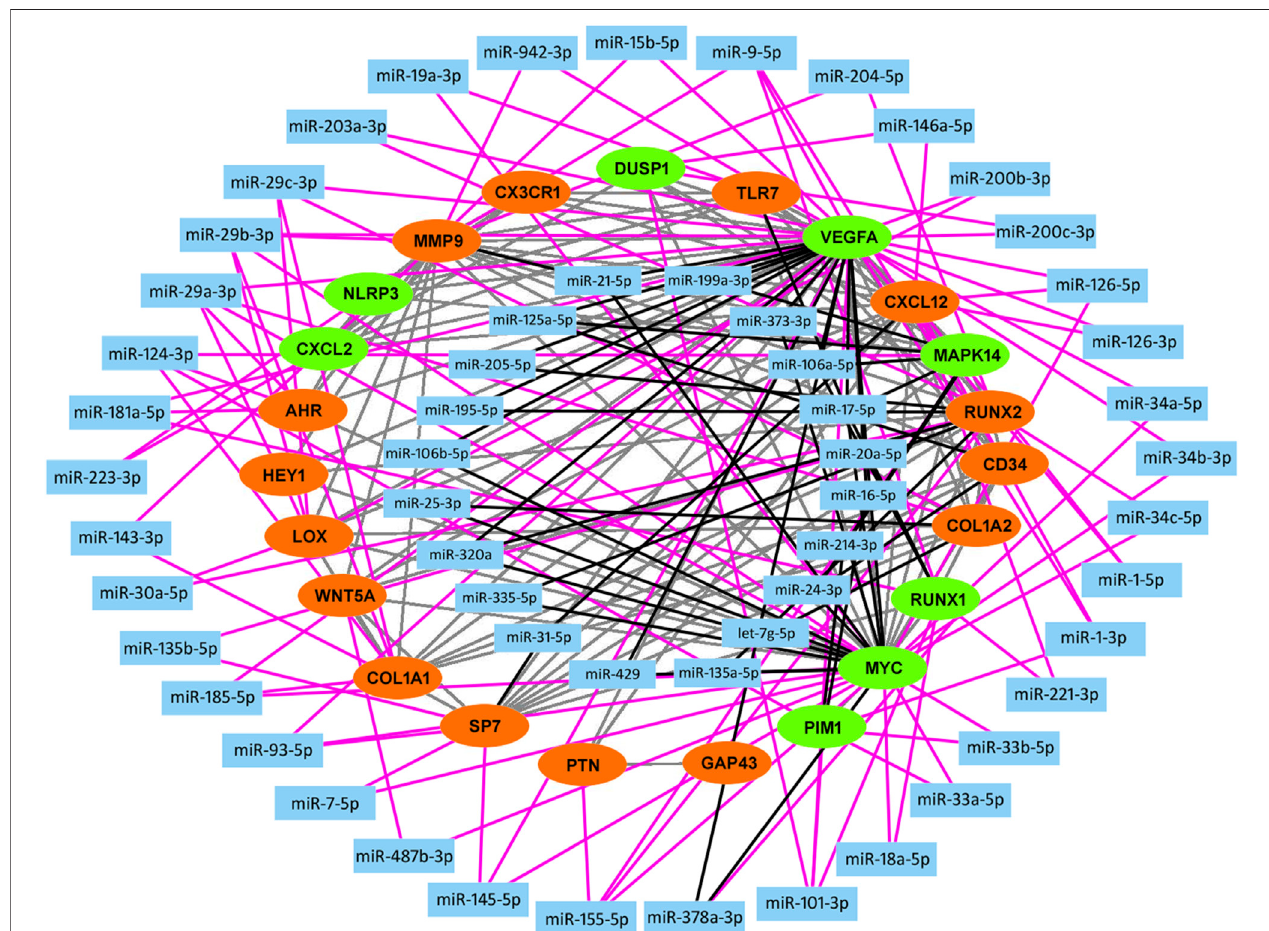
FIGURE5 | Construction ofmiRNA-mRNA network. Atotal of23 knee OA-related keygenes(red, upregulated; green, downregulated) areused inconstruction of miRNA-mRNA network backbone. Key miRNAs are then screened out by miRTarBase database and visualized in Cytoscape. Grey line, protein-protein interaction; Black line, interaction between key gene and key miRNA which belongs to inner circle. Pink line, interaction between key gene and keymiRNAwhich belongs tooutside circle.